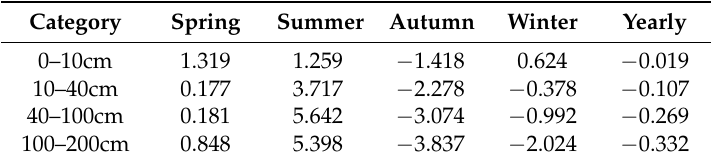
Table 2. The climate tendency rate of soil moisture in four layers (Unit: kg/m 2 /10a). Category